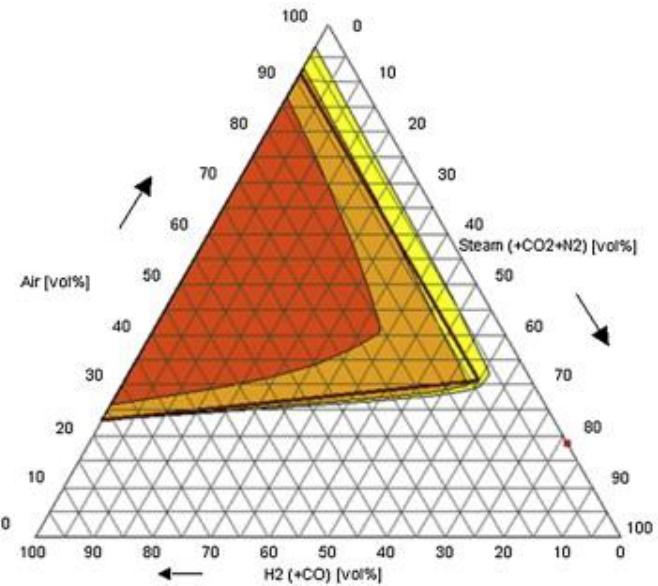
Figure 5. Shapiro diagram for hydrogen-air-steam mixtures at 1 bar and ambient. The diluent concentration is added to the steam concentration [17].